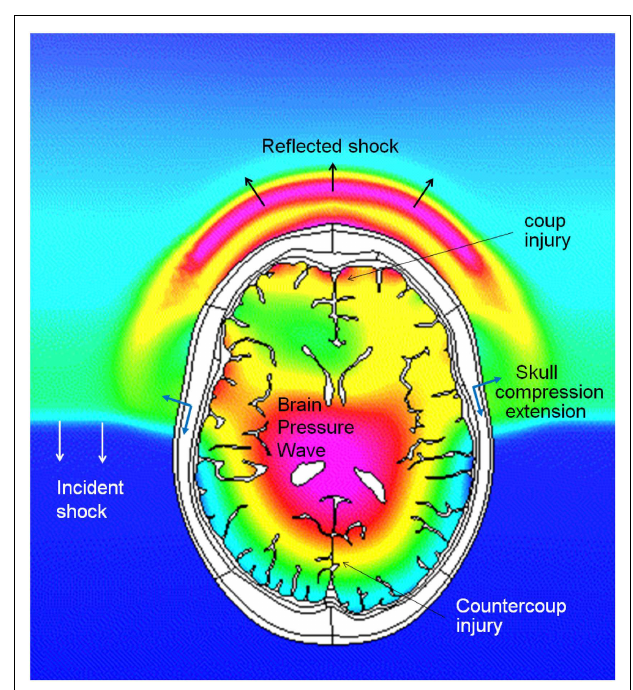
FIGURE 3 | Coupled simulations of CFD blast wave and FEM biomechanics of a human head . Pressure profiles in the air and in the brain during intracranial pressure wave penetration. Note that the intracranial pressure wave is faster than the incident shock wave in the